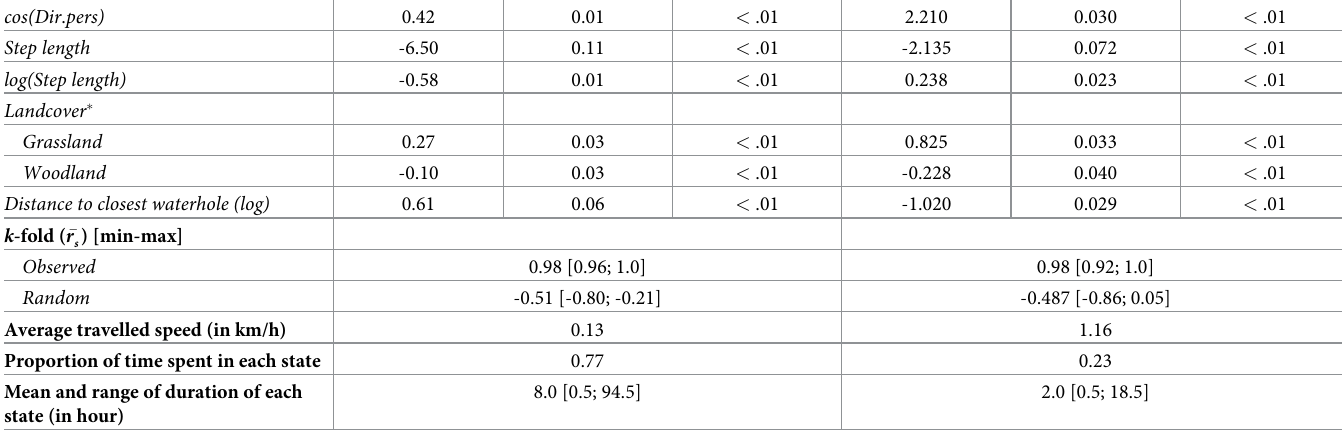
Identifying the onset of migration and habitat selection during the different phases of the migratory behavior The HMM-SSF identified the onset of mule deer migration between 11 March (first migration) and 4 May (last migration, Fig 3). Overall, the starting date of migration identified by the HMM-SSF was similar to that obtained by net squared displacement analysis (Fig 3), but the HMM-SSF provided information on selection behavior of individuals according to their movement modes.